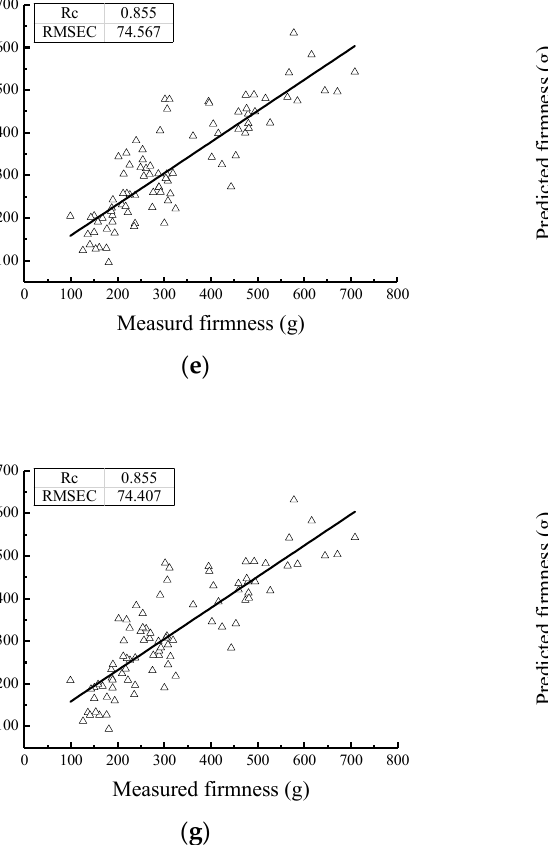
Figure 13. Prediction results of the firmness of the pears using the PLS method at different critical temperatures: ( a ) the MSC calibration set; ( b ) the MSC validation set; ( c ) the S-G-MSC calibration set;